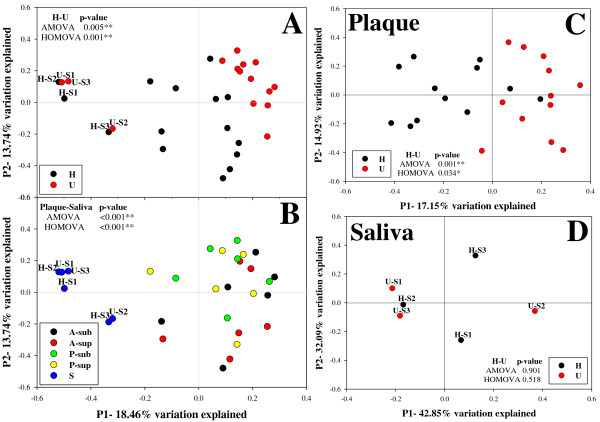
ThetaYC-based analysis of bacterial community structures. Community structures from H and U Groups (A) or from the different sites (B) were interrogated using principal coordinate analysis (PCoA) of thetaYC distance matrix. Each point corresponds to a microbial community, with color indicating its category. Percentages of variation explained by the plotted principal coordinates were indicated on the axes.